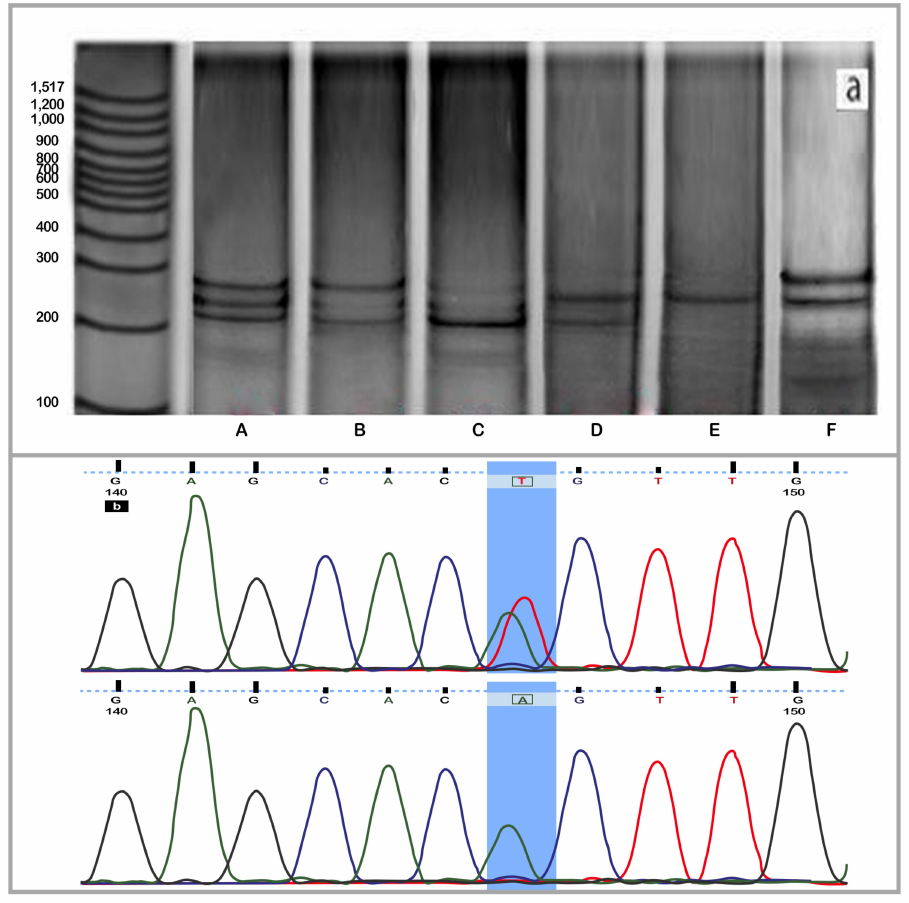
Figure 1. SSCP patterns for 3 (cid:48) UTR of ( a ) the let-7 miRNA gene (225 bp), and the sequence chro- matogram ( b ) for the let-7 miRNA gene. The chromatogram in the top represents the sequence having SNP, and the chromatogram in the bottom represents the sequence without SNP. A, B, C, D, E and F are different patterns of let-7 miRNA gene